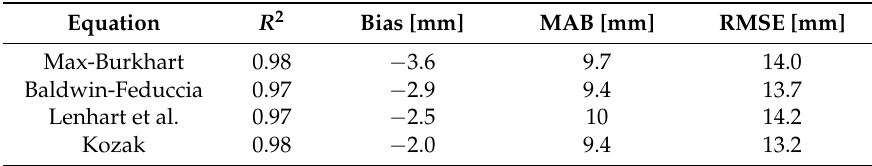
Table 7. Validation of the PPC-based models with ground measured